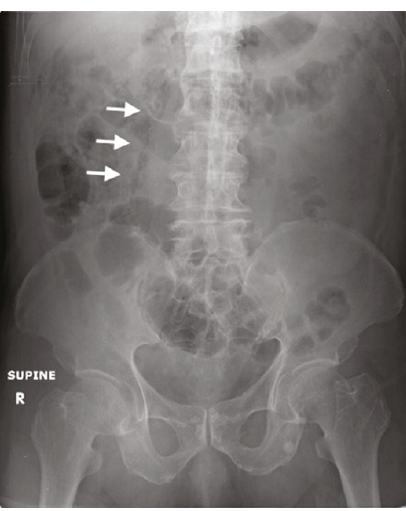
Figure1:AbdominalX-rayshowinglucencyoutliningtherightcrus of the diaphragm and extending along the right psoas muscle.